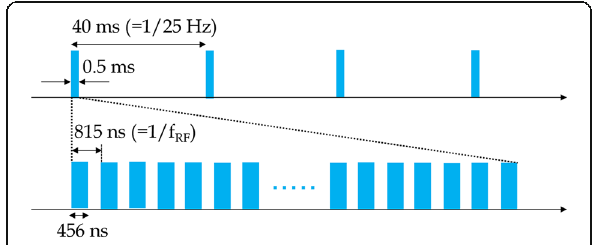
Fig. 6 Temporal structure of the J-PARC linac beam; macro pulses created by the ion source (upper), and intermediate pulses formed by the chopper (lower)